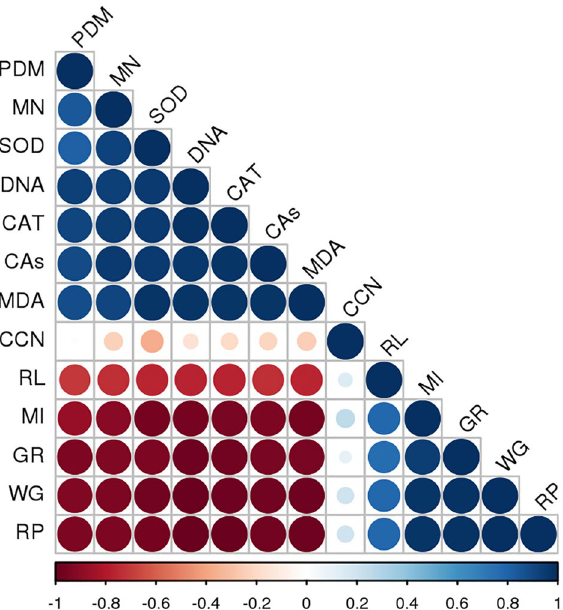
Figure 8. Correlation of pendimethalin and curcumin with cytological, physiological and biochemical analysis ( PDM : pendimethalin, MN : micronucleus, SOD : superoxide dismutase, DNA : DNA arbitrary unit bridge, CAT : catalase, CAs : chromosomal abnormalities, MDA : malondialdehyde, CCN : curcumin, RL : root length, MI : mitotic index, GR : glutathione reductase, WG : weight gain, RP : rooting percentage. Pearson correlation analysis (two-sided) was performed and visualized with Rstudio software. Positive correlations are shown in blue and negative correlations in red. The color intensity and the size of the circle are proportional to the correlation